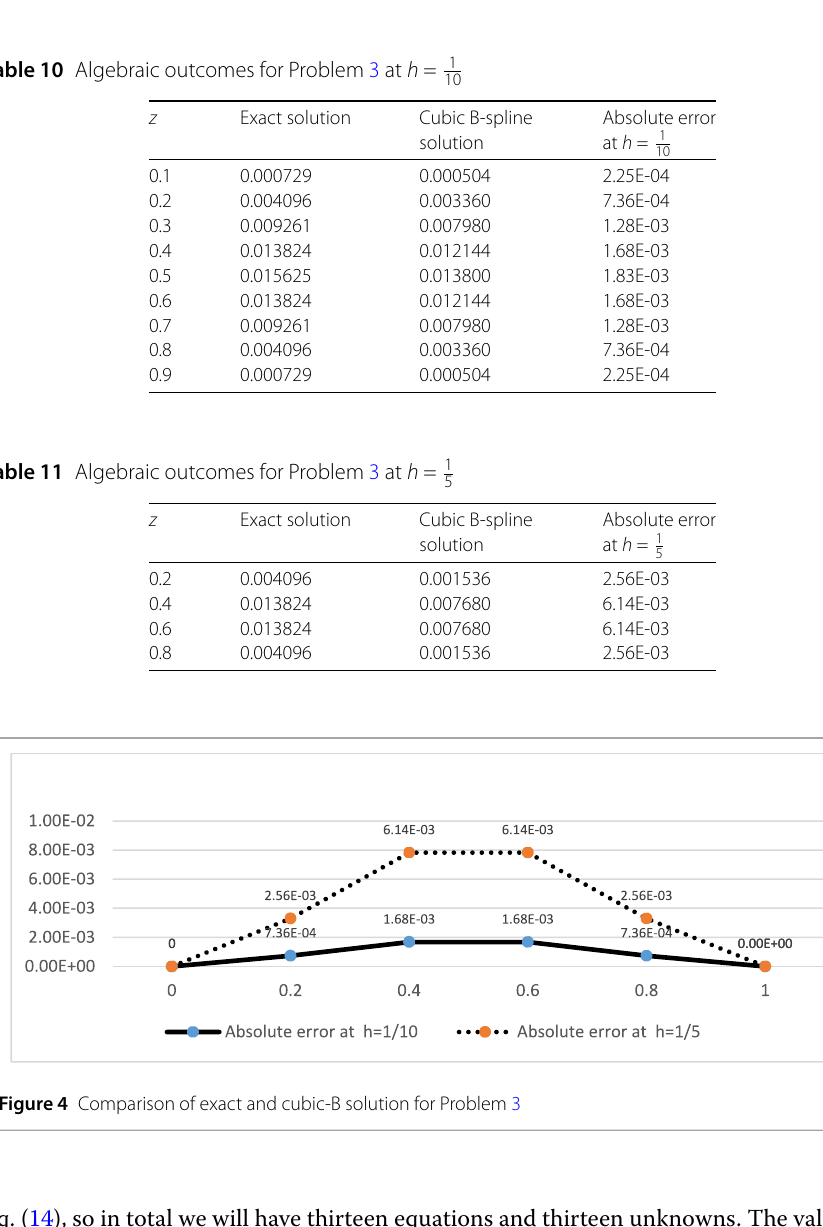
Table 10 Algebraic outcomes for Problem 3 at h = 1